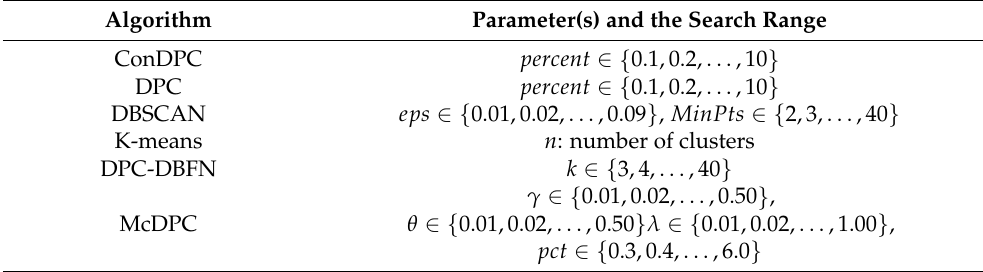
Table 1. Information of the input parameters. Algorithm